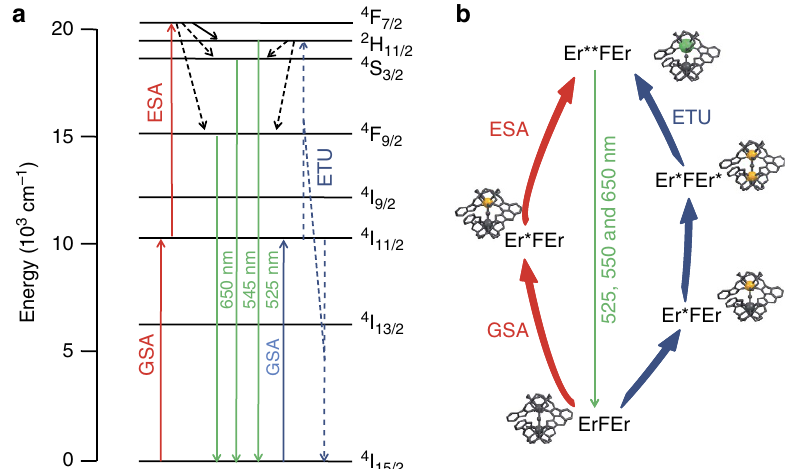
Figure 7 | Energy level diagram and mechanisms of the UC process. ( a ) The different mechanisms (ETU in blue and excited state absorption (ESA) in red) for the UC process are presented in the energy level diagram of the Er ion. In both cases, the first step is the excitation to the 4 I 11/2 level upon excitation at 980nm. For ESA, the erbium ion in the excited state absorbs a second photon to reach the upper levels and relaxation to the 2 H 11/2 , 4 S 3/2 and 4 F 9/2 precedes the emission of the UC signal (green arrows). For ETU, the higher excited state is reached by energy transfer from the second Er atom itself in the 4 I 11/2 excited state. ( b ) Schematic representations of the two mechanisms (the vertical positions are not representative of the energy levels of the different excited